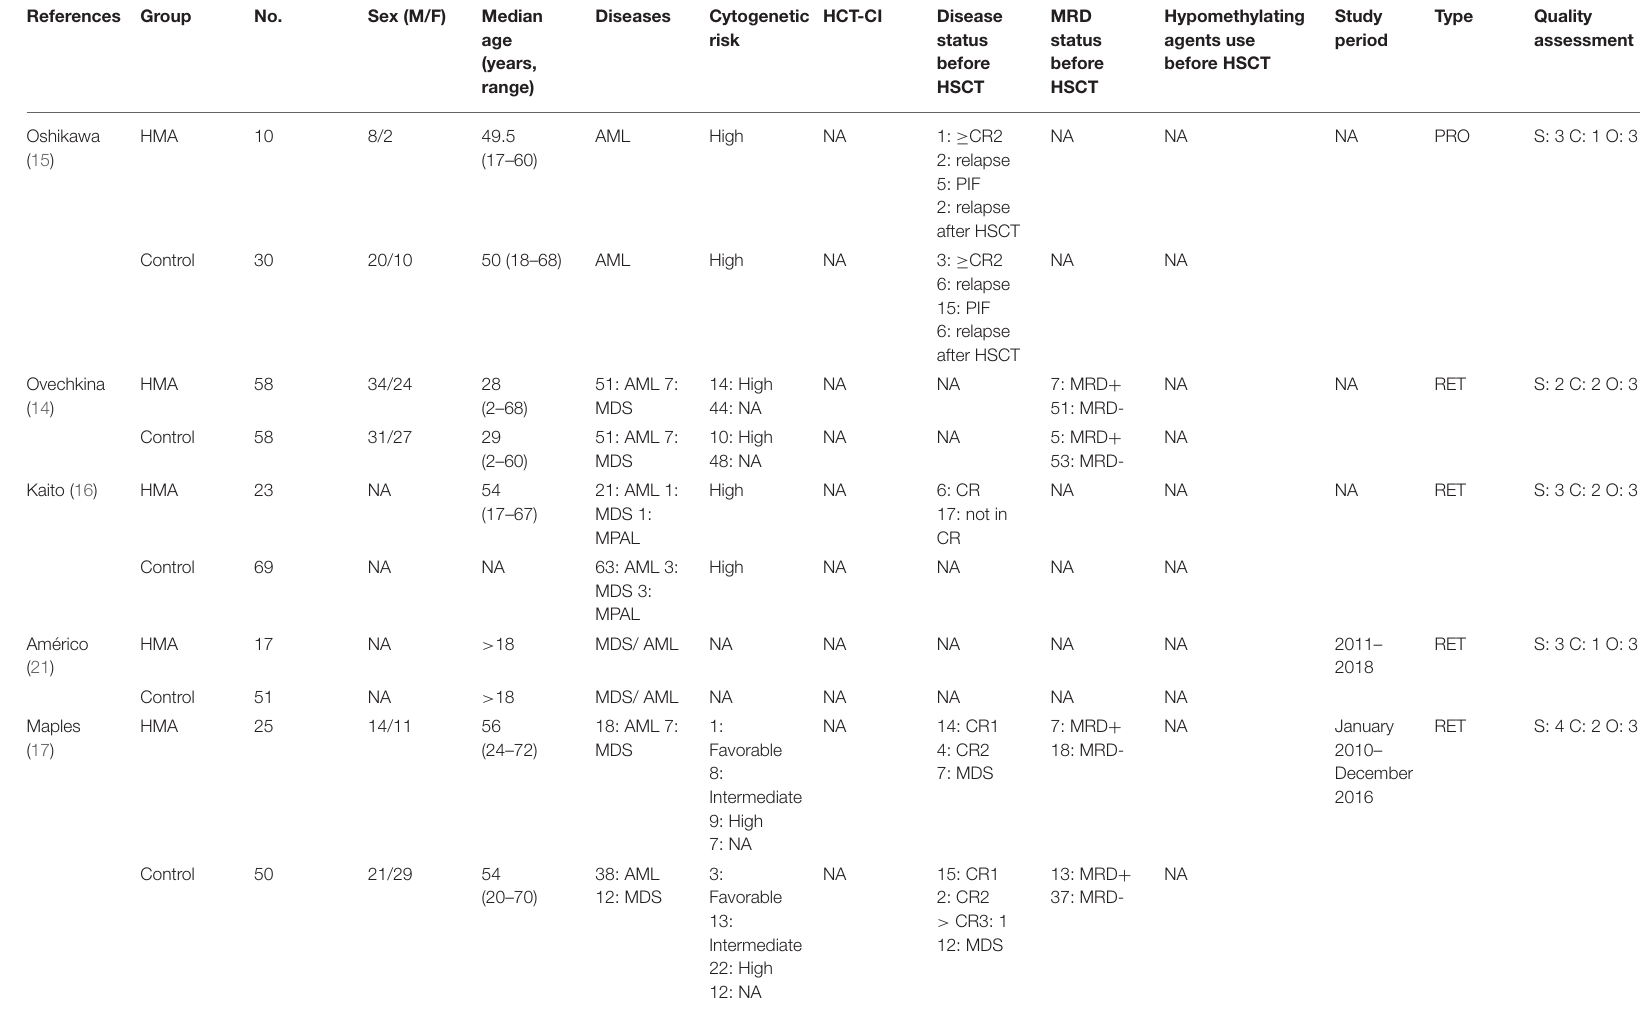
TABLE 1 | Patient’s baseline characteristics of studies included in the meta-analysis. References